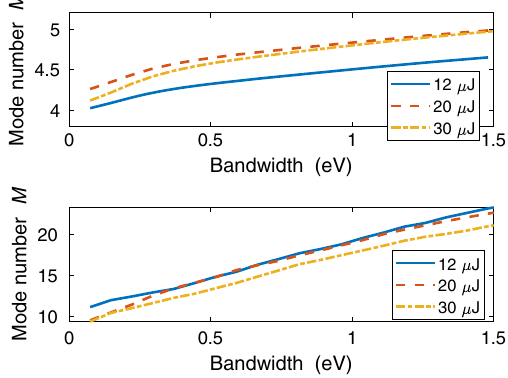
FIG. 14. The effective number of modes M as a function of the integration bandwidth for self-seeding (top) and SASE (bottom) under different LH energies at U15. The integration bandwidth is centered on the amplified seed